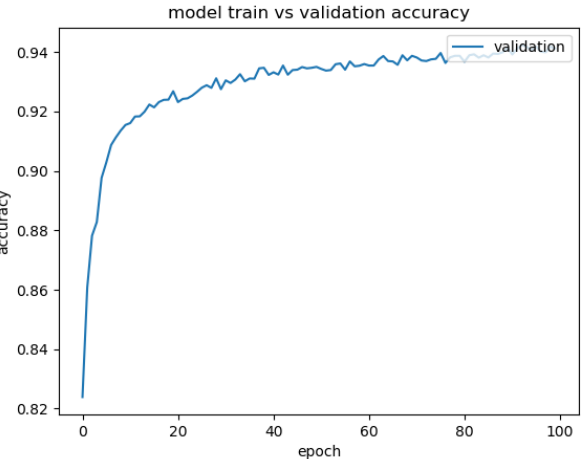
Figure 7. Accuracy of prediction results.